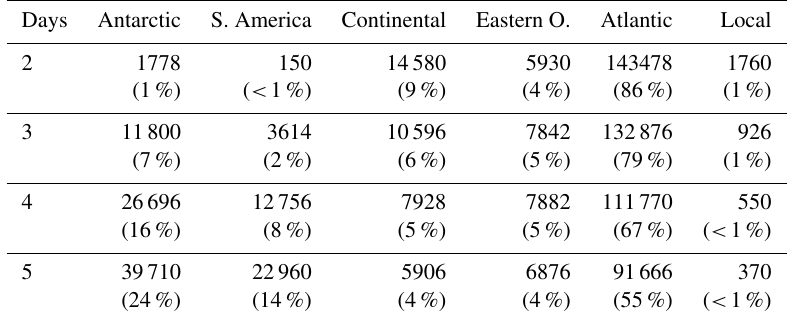
Table 1. Impact of travel time cutoff on air parcels source region categorisation. Total and relative allocation of trajectories to each source region depending on air parcel travel